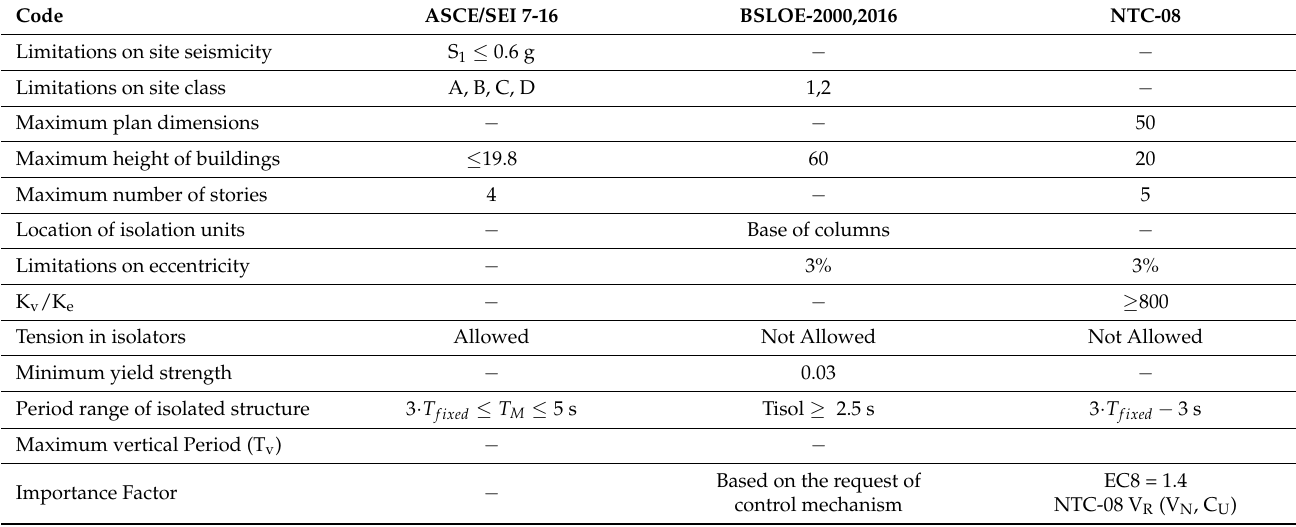
Table 1. Limitations and essentials